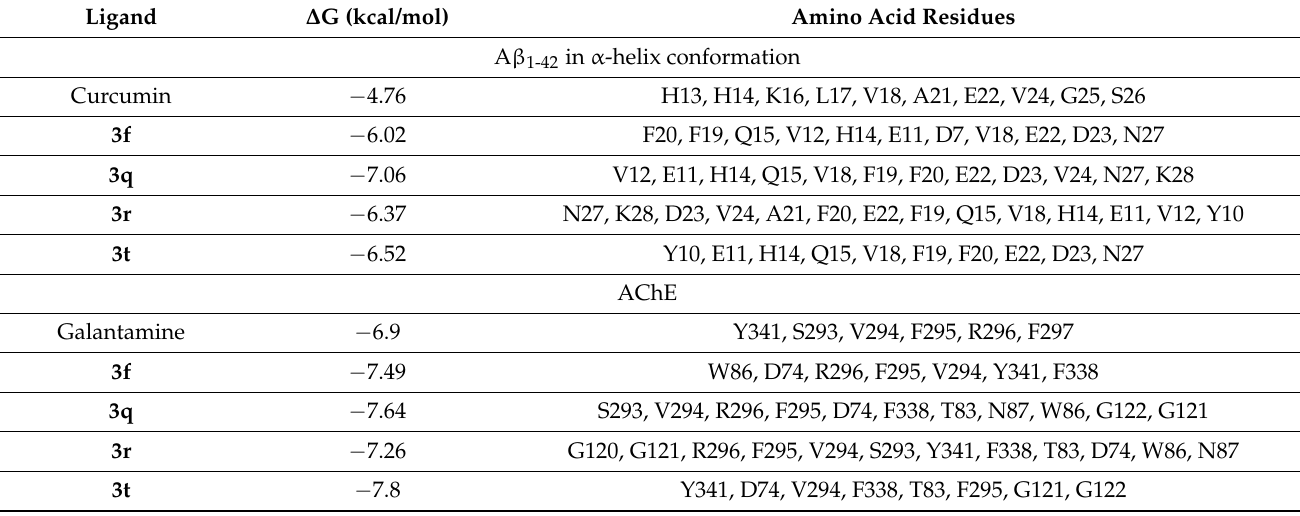
Table 1. ∆ G values and amino acids of interaction obtained by docking simulations for